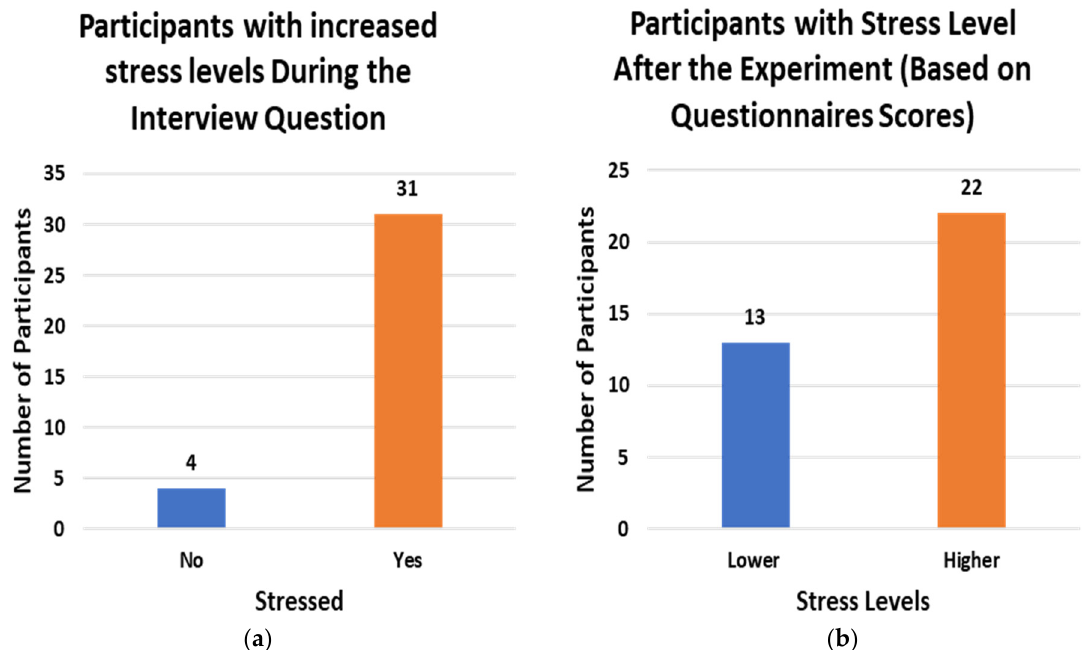
Figure 6. Participants with increased stress levels ( a ) based on Questionnaire score ( b ) asked during Interview.